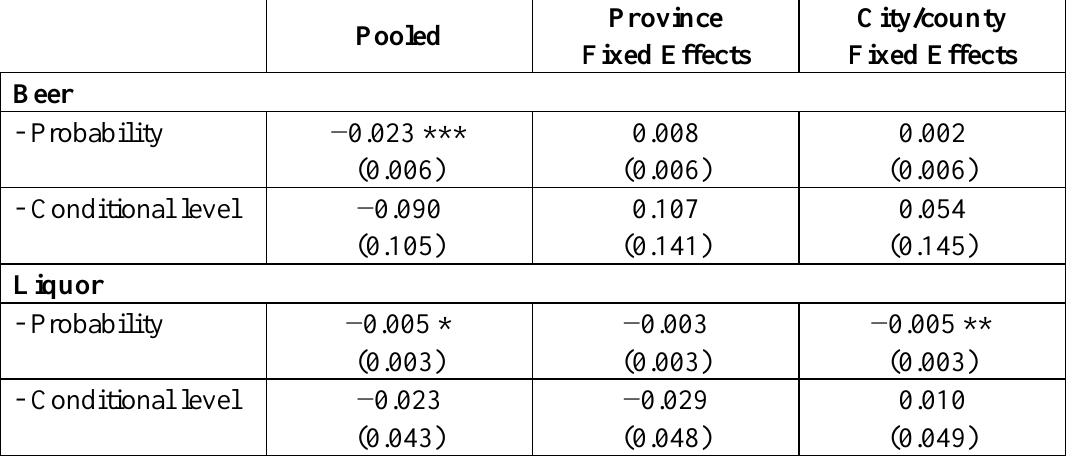
Table 4. Price elasticities of alcohol demand in China,